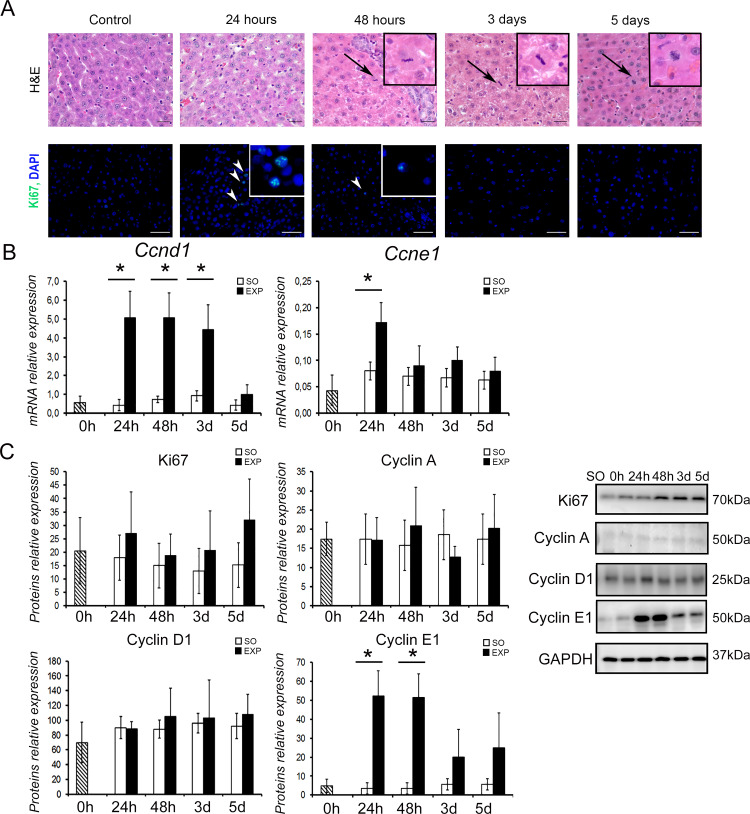
Hepatocyte proliferation in the intact liver after splenectomy: (A) Mitotic figures in hepatocytes, hematoxylin-eosin staining (H&E) and Ki67 expression (FITC, nuclei are counterstained DAPI). Control—sham operated animals; Bars, 50 μm;. Arrows indicate mitotic figures in hepatocytes; Arrowheads indicate Ki67+ cells, (B) Expression of Ccnd1 and Ccne1 in the liver after splenectomy, (C) Content of Ki67, cyclin A, cyclin D1 and cyclin E1 proteins in the liver after splenectomy.